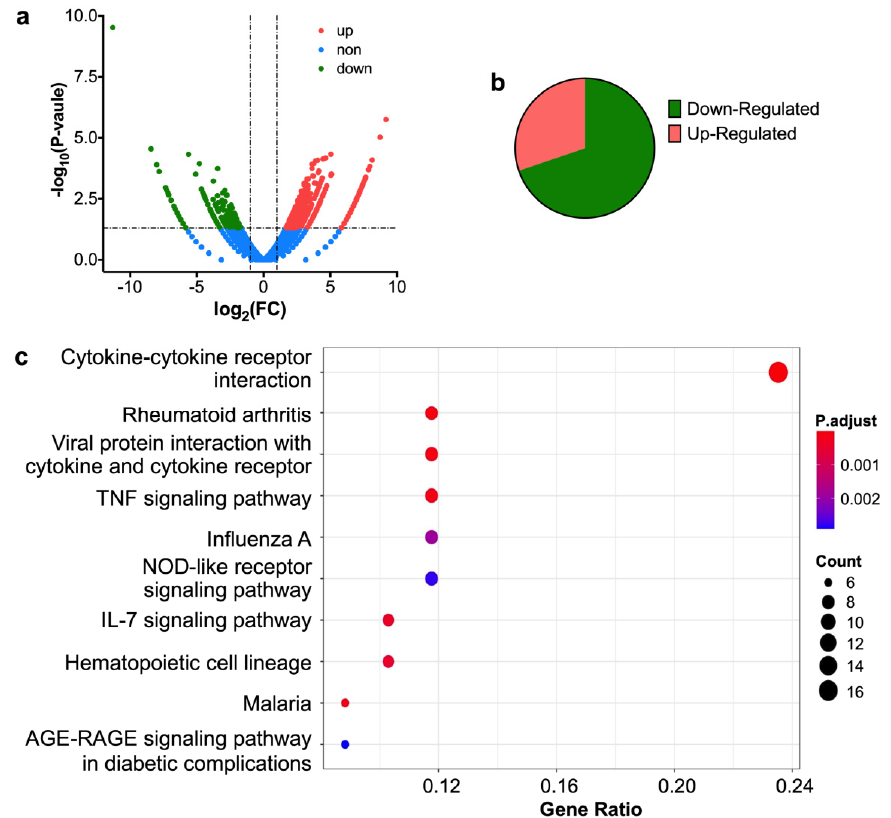
Figure 3. RNA-seq analysis of JNJ-7706621 on the gene expression profile in SK-MEL-2 cells. ( a ) The volcano plots visualize differentially expressed genes (DEGs) between the JNJ-7706621-treated and the control group. The p < 0.05 was used as the significance threshold to determine the significance of DEGs. ( b ) The percentage of up-regulated and down-regulated genes in DEGs. ( c ) KEGG pathway enrichment of JNJ-7706621-regulated genes. The range of p -value is (0,1). The experiments were parallelly repeated in twice.